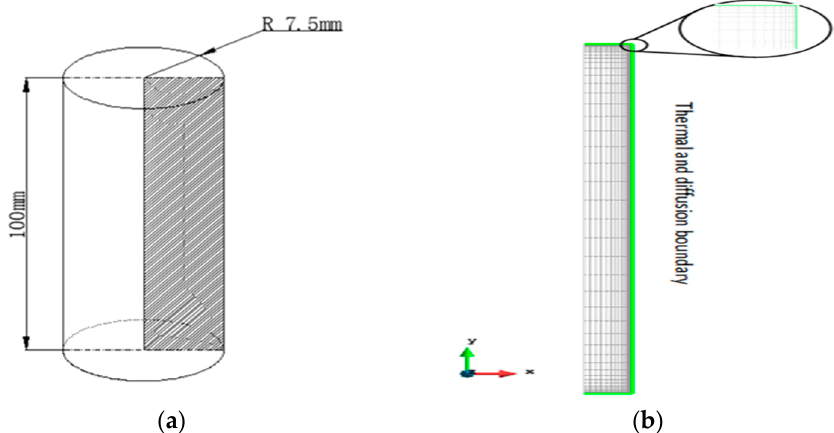
Figure 5. FEM model and mesh. ( a ) Schematic diagram of the sample; ( b ) Finite element mesh.